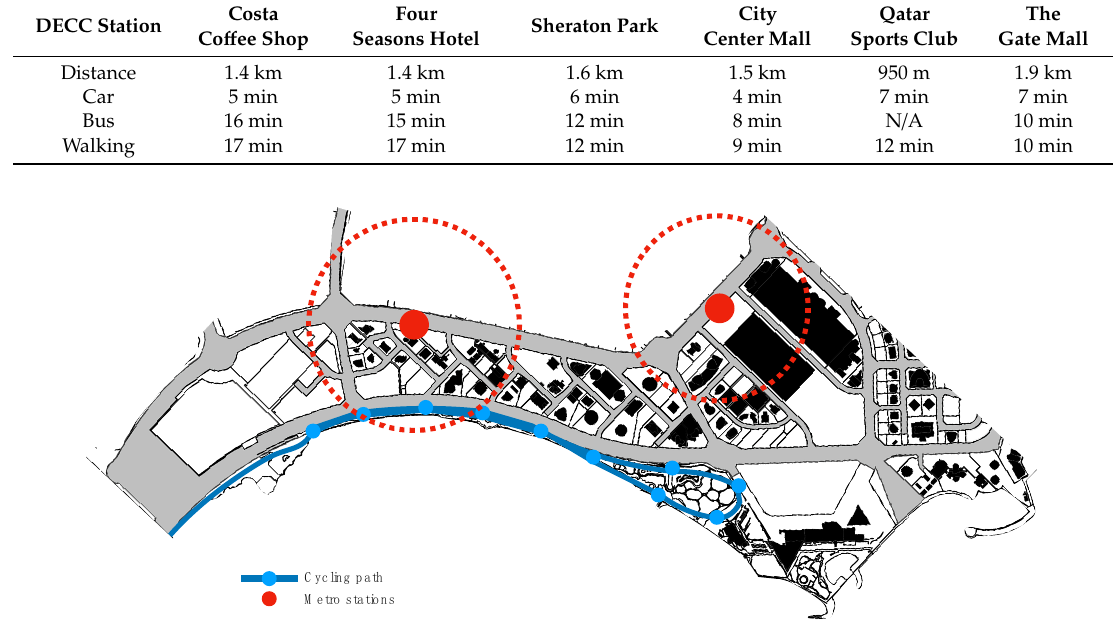
Figure 10. Corniche cycling network pattern. Table 2. The distance via transportation modes between West Bay Metro stations and nearby landmarks.